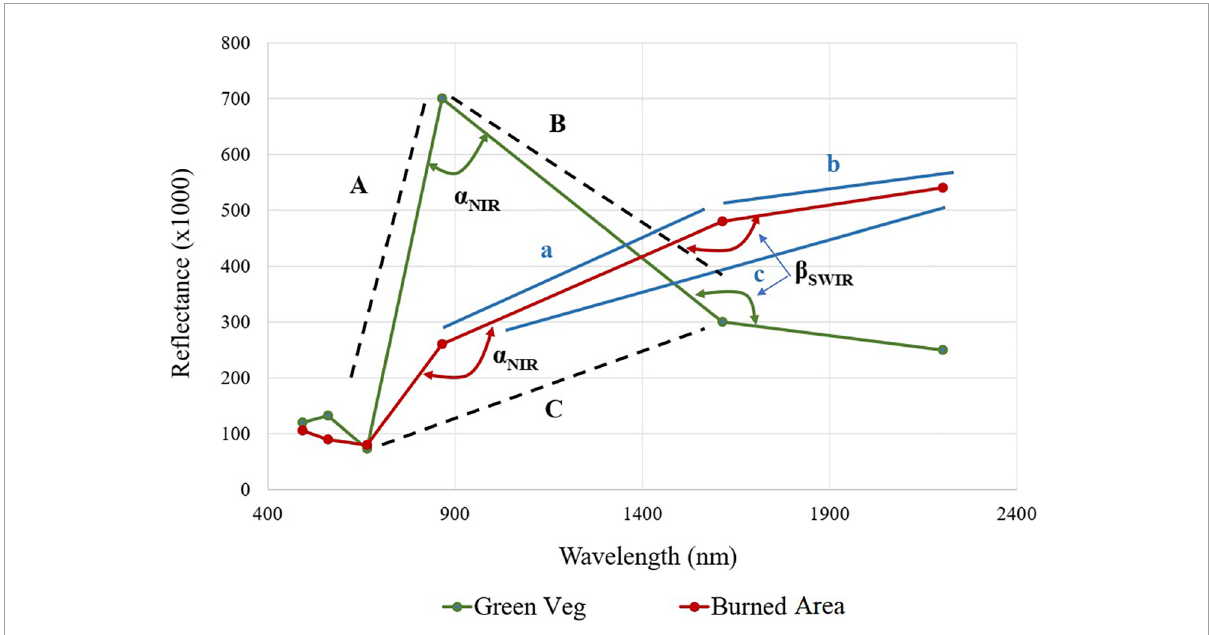
FIGURE3 Depiction of the equation variables of the band angle indices SANI, SASI, and ANIR. SANI and SASI indices locate in the triangle formed by blue-filled lines (a–c) and centered at sSWIR (1610 nm). ANIR index ( α NIR ) is based on the triangle formed by black dashed lines (A–C) and centered at NIR. (a–c) Correspond with the nomenclature used in equations in Table 1 for SANI and SASI